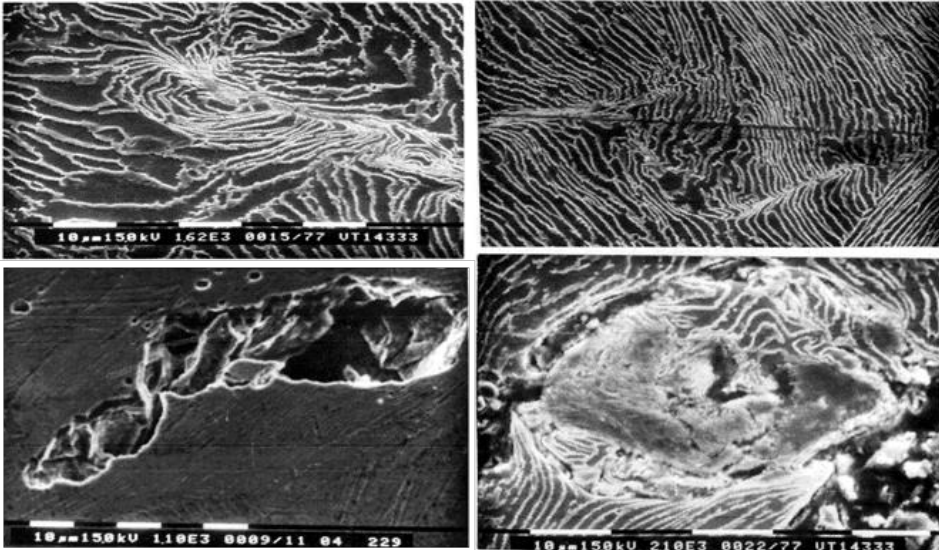
Figure 5. The rotational cells in shock-deformed VT14 titanium alloy targets.